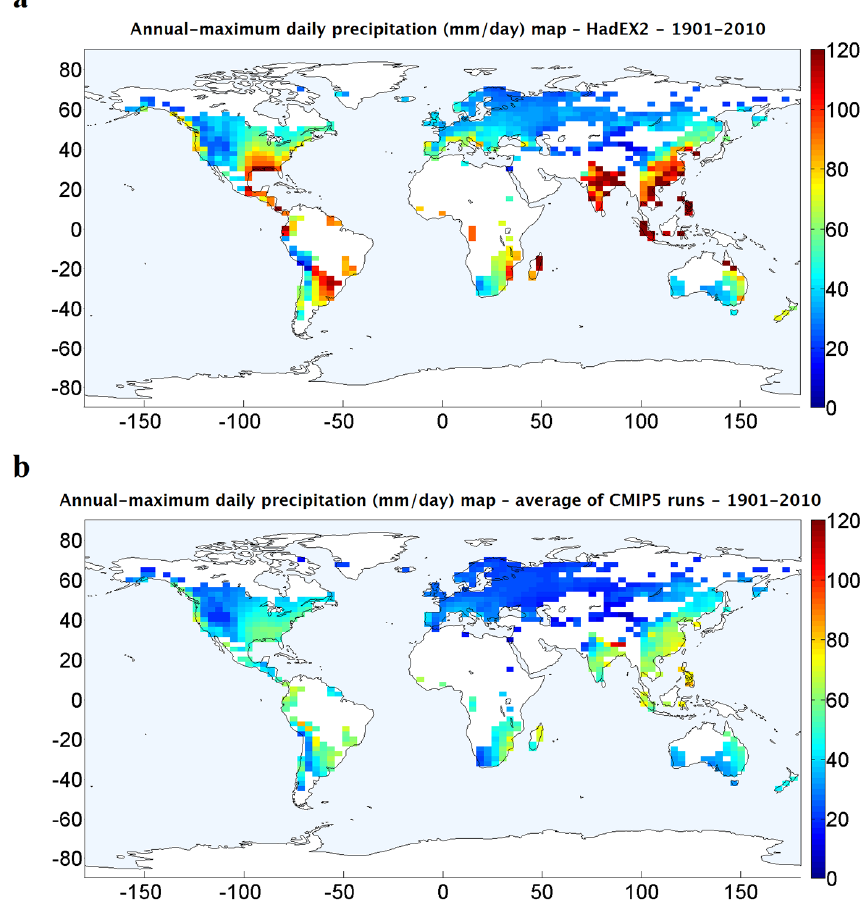
Figure 3. HadEX2 observational data versus CMIP5 averaged results of global extreme precipitation in 1901–2010 – annual-maximum daily precipitation map (mmday − 1 ) for (a) HadEX2 and (b) the average of CMIP5 model runs.